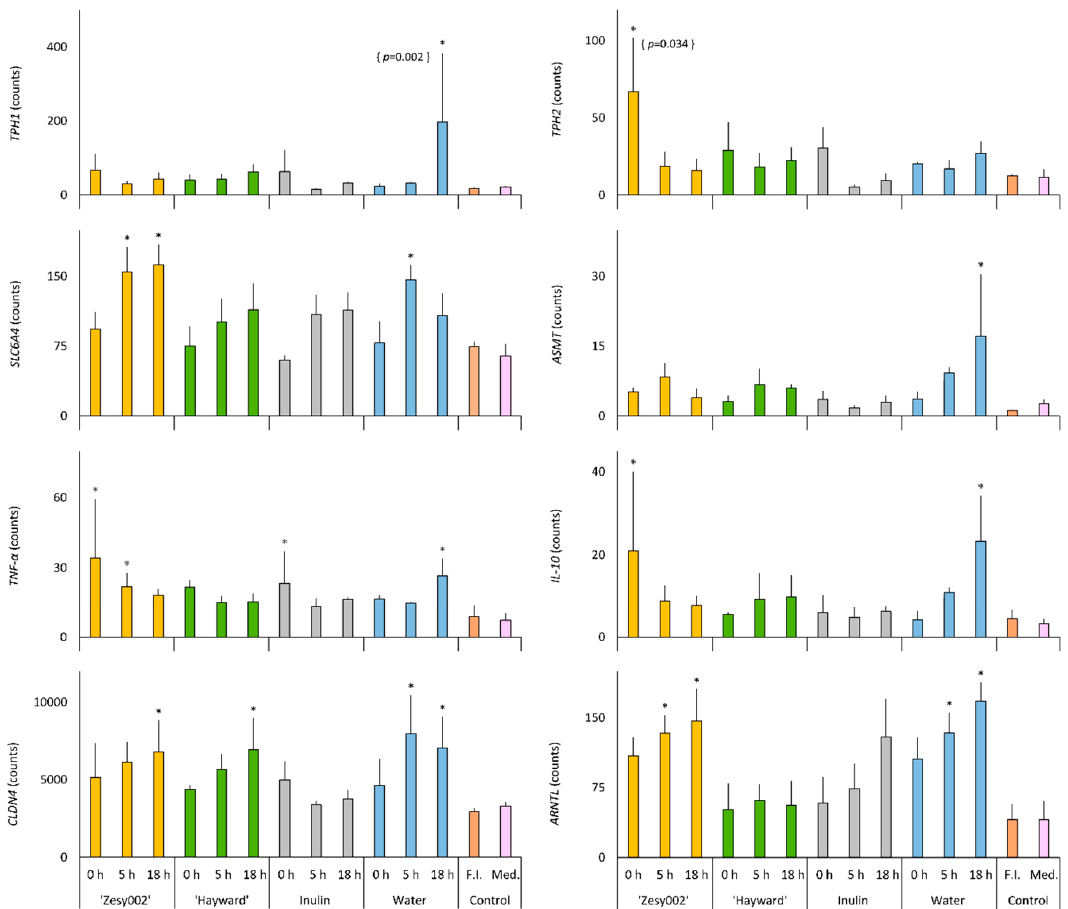
Figure 4. Gene expression data from Caco-2 cells incubated for 3 h ( n = 3) with kiwifruit, inulin or water fermenta collected at 0 h (minus fecal inoculum), 5 and 18 h, or the controls, i.e., fecal inoculum (F.I.) used for the fermentation experiment, and the background medium (Med.). The genes studied include the tryptophan hydroxylase isoforms, TPH1 and TPH2 , serotonin transporter SLC6A4 , N -acetylserotonin O -methyltransferase ASMT , tumor necrosis factor- α TNF- α , interleukin-10 IL-10 , claudin4 CLDN4 and clock gene ARNTL1 . Values are the mean counts ± standard errors of means. The counts have been normalized to five reference genes. Significant difference ( p < 0.05) from medium control is indicated by *. Significant differences between fermenta within a substrate group were p = 0.034 for TPH2 with ‘Zesy002’ and p = 0.002 for TPH1 with water.